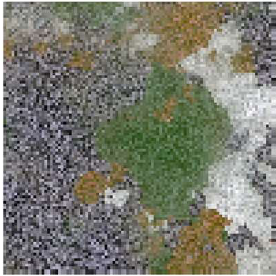
Figure 5. The true color image of the synthetic dataset.